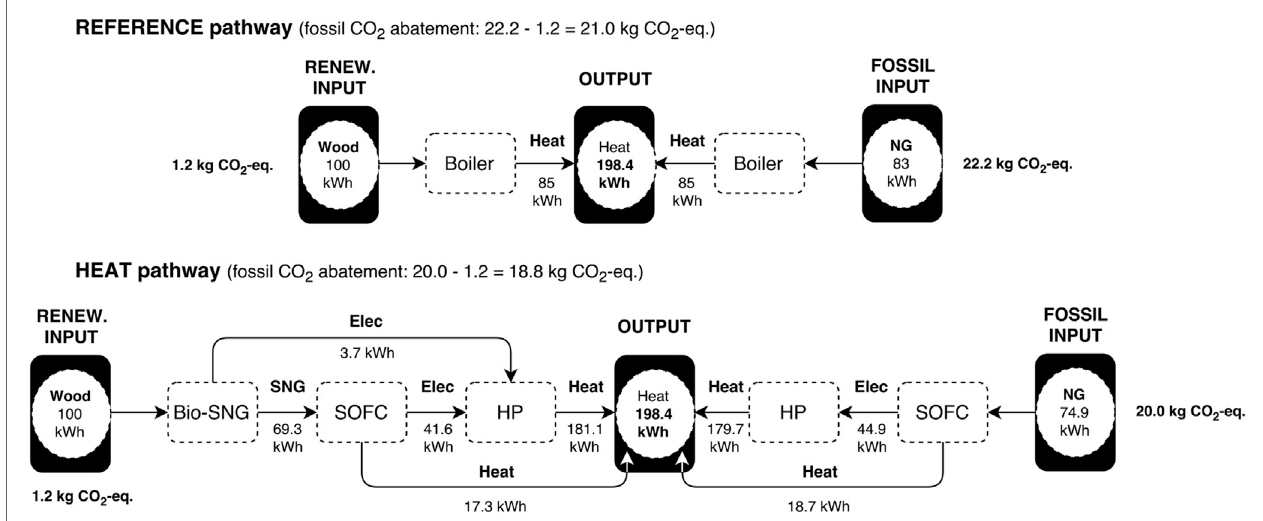
FigUre 3 | Reference substitution pathway and substitution pathway example for the Heat approach.